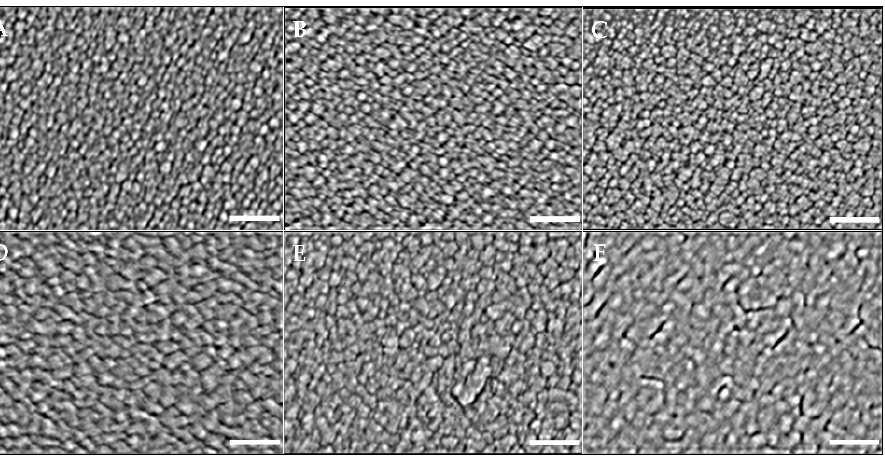
Figure 3. Images of the FESEM morphologies using the magnification of × 200,000 to analyze Samples ( A – E ). The size of the white bars in each sub-image is 100 nm. Samples ( A – E ) show the nanoparticle structures, and Sample ( F ) shows a liquid-like structure.